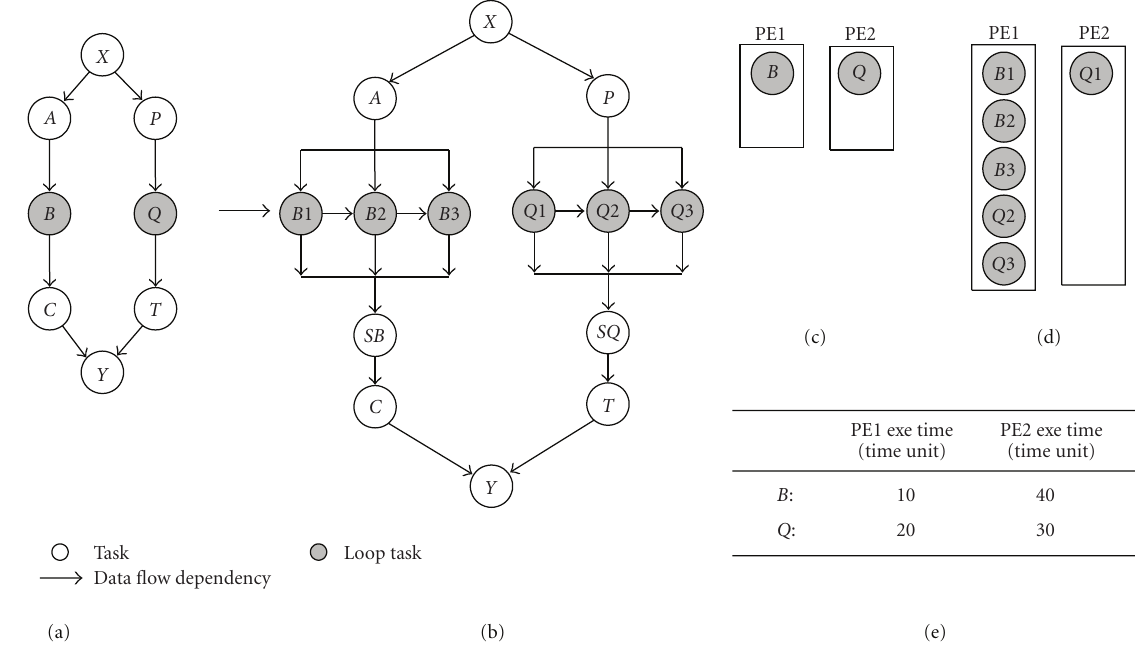
Figure 4: Mapping/scheduling example for loop unrolling and fission with data dependencies between iterations: (a) Task graph containing two parallel loops having data dependency between iterations. (b) Task graph after unrolling the two loops for three iterations. (c) Mapping and scheduling solution before unrolling and fission, overall processing time for 3 iterations is 90 time units. (d) Mapping and scheduling solution after unrolling and fission, overall processing time is 70 time units. (e) Execution time of one iteration of the loop body for di ff erent processing elements. Higher inter-loop parallelism is achieved by unrolling two loops.